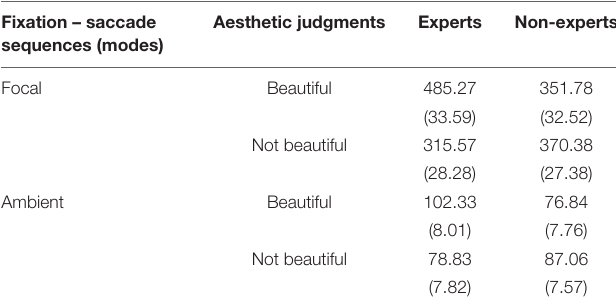
TABLE 1 | Mean number ( SD ) of fixations in two different fixation – saccade sequences entering the EFRP analyses across participants and experimental